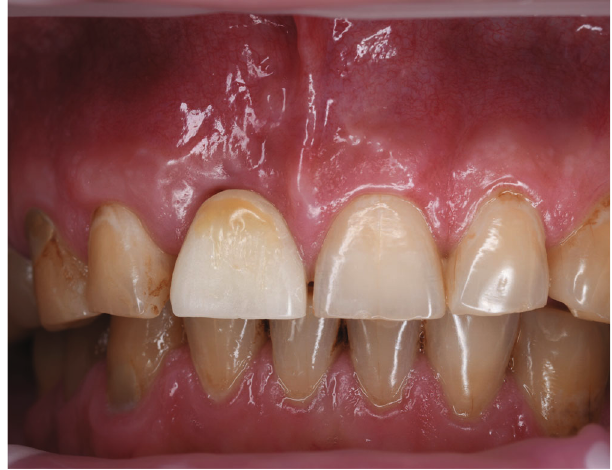
Figure 15: Soft-tissue maturation 2.5 months